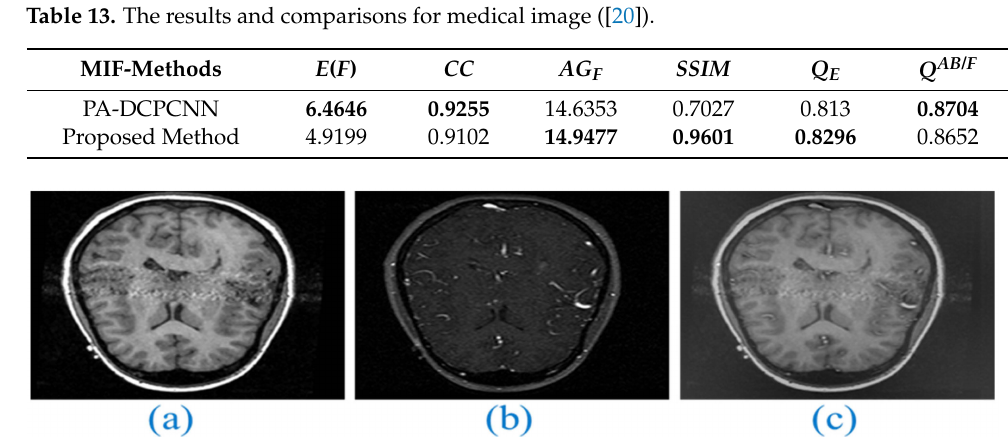
Figure 21. Medical Image Pair: ( a , b ) are source images, ( c ) Final fused image.